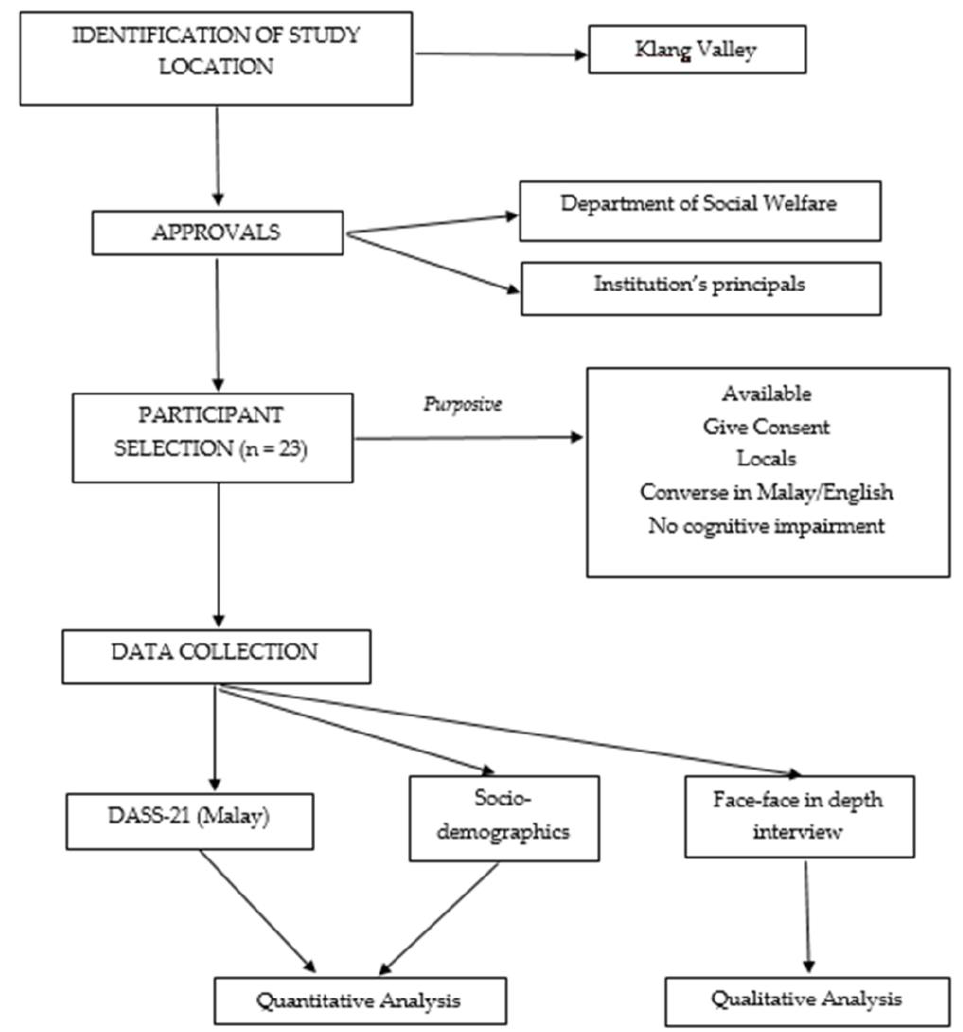
Figure 1. Study design of